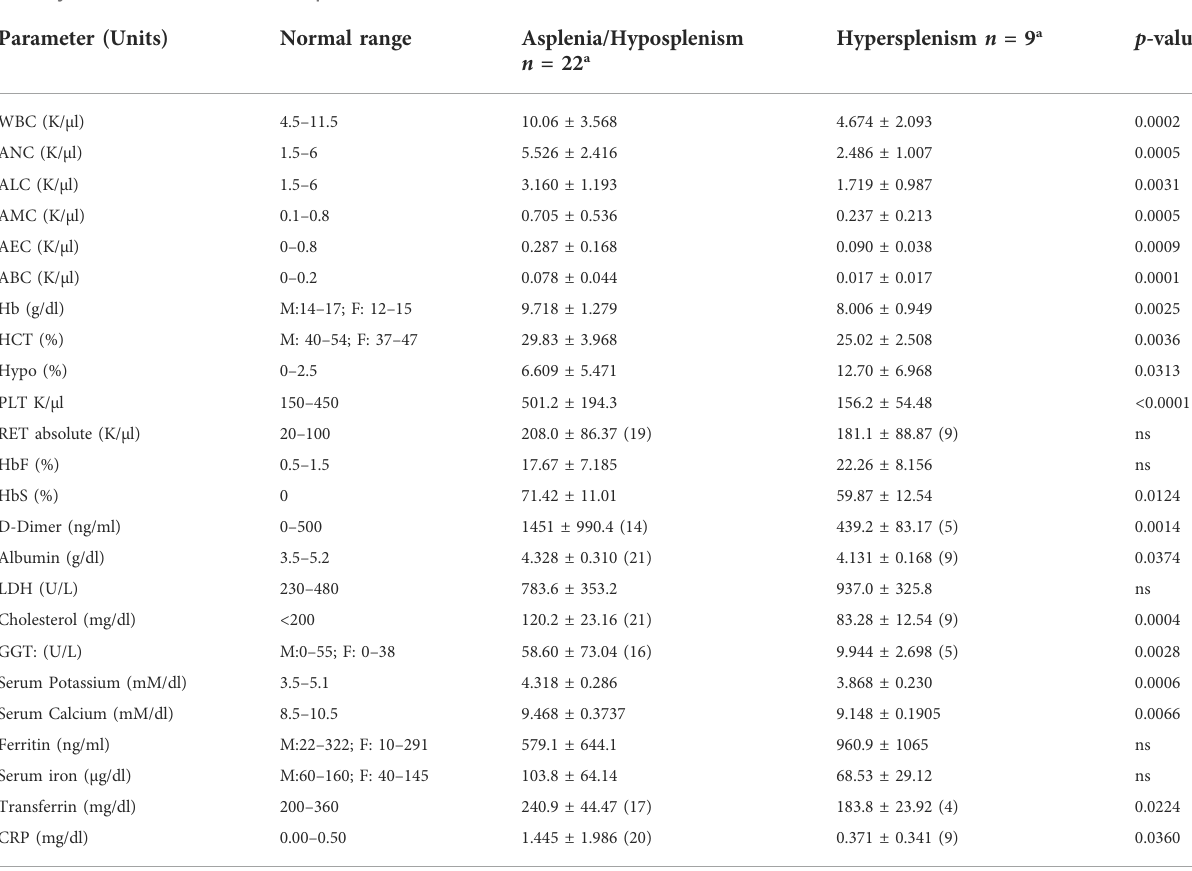
TABLE 2 CBC and biochemistry parameters in asplenic/hyposplenic compared to hypersplenic SCD subjects. Normal ranges are presented in accordance with the criteria accepted by the EMC Lab divisions. The data is presented as average ± Standard Deviation (SD); Signi fi cance was calculated using the two-tailed Mann-Whitney as p < 0.05. WBC, White blood count, ANC, Absolute Neutrophil count, ALC, Absolute lymphocyte count, AMC, Absolute monocyte count, AEC, Absolute eosinophil count, ABC, Absolute basophil count, Hb, Hemoglobin, HCT, Hematocrit, Hypo, Hypochromic Red Cells, PLT, Platelet, RET: Reticulocyte, HbF, Fetal hemoglobin, HbS, S hemoglobin, LDH, Lactic dehydrogenase, GGT, Gamma Glutamyl Transferase, CRP, C reactive protein. RBC, Red blood